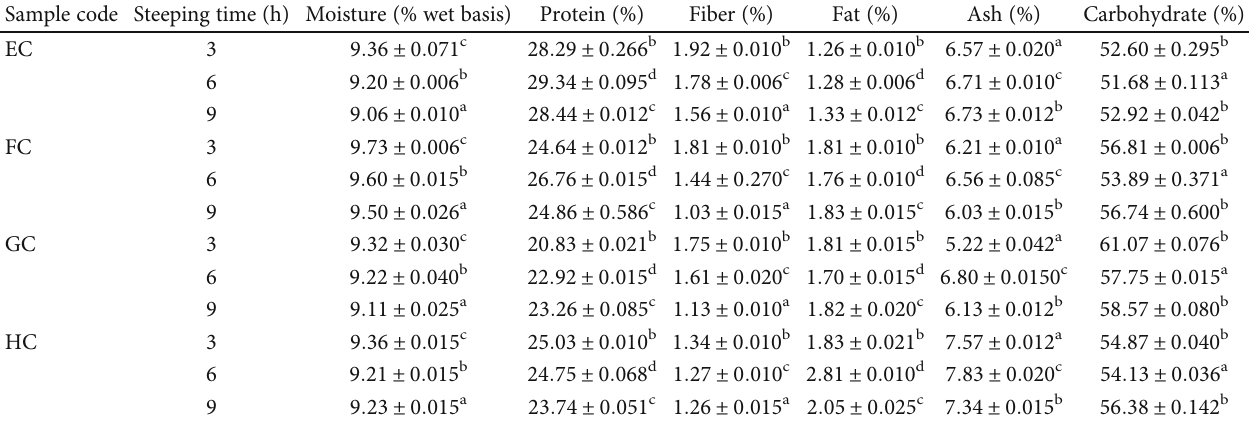
Table 2: Proximate composition of the cassava-cowpea-orange fl eshed sweet potato (OFSP) blend. Sample code Steeping time (h) Moisture (% wet